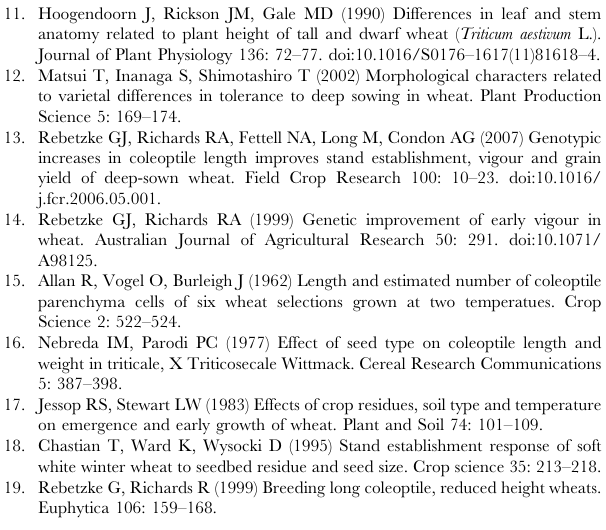
Table S1 Names of the 662 cultivars evaluated in the coleoptile length and emergence